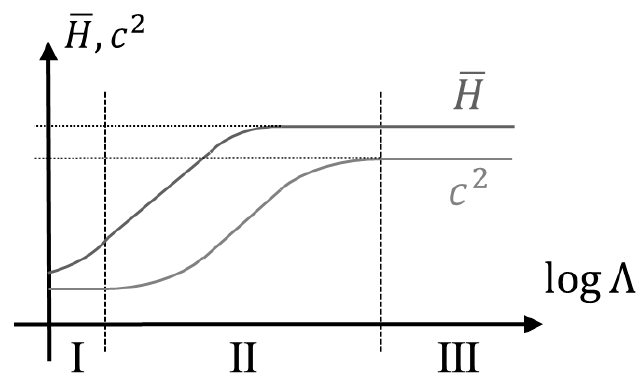
Figure 2. Normalized hardness, H = H / σ y , and area ratio, c 2 , as functions of ln Λ , Λ defined according to Equiation (1). Schematic of the correlation of sharp indentation testing of elastic-ideally plastic materials. The three levels of indentation responses, I, II and III, are also indicated. Approximately, level II contact initiates at Λ = 3 level III contact at Λ = 900. The H -curve flattens out at (approximately) Λ = 30.